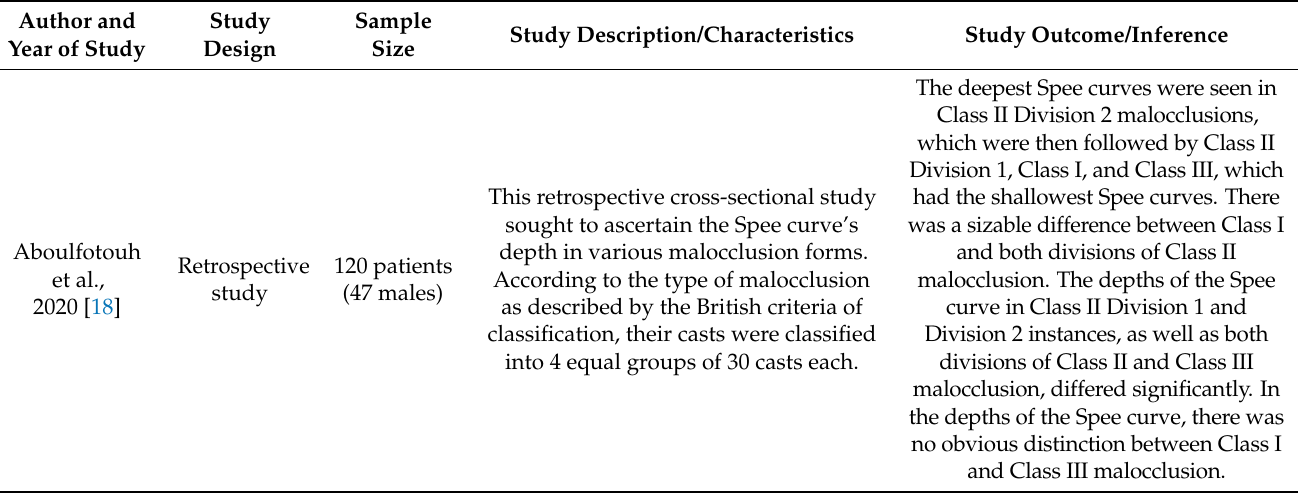
Table 2. Description and outcomes as observed in the studies selected for the systematic